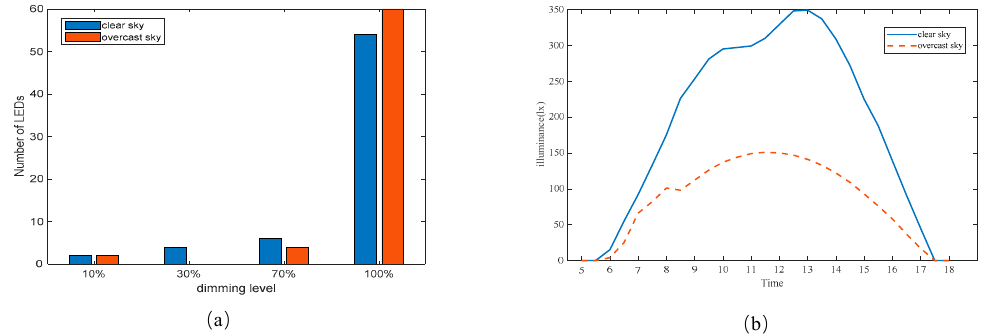
Figure 15. The effect of the weather conditions on daylight harvesting: ( a ) the distribution of dimming levels at 10:00 a.m. under a clear sky and overcast sky conditions and ( b ) the values of the light sensors at different times.